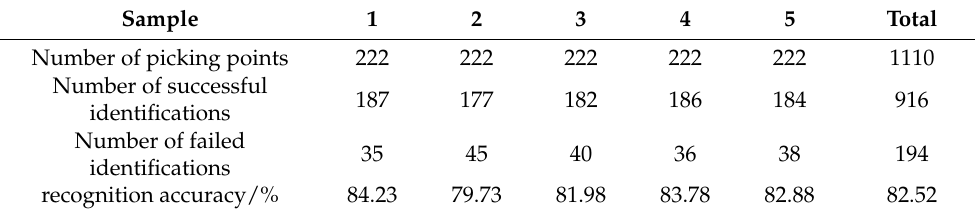
Table 8. Identification results of picking point for single bud.